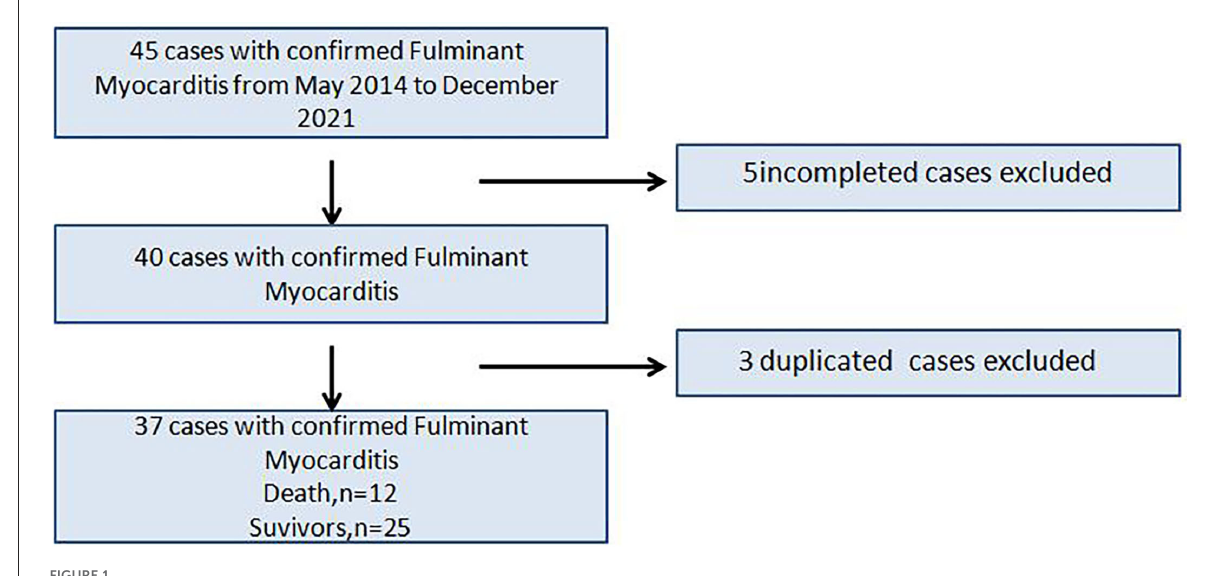
FIGURE1 Flowchart of patient recruitment.